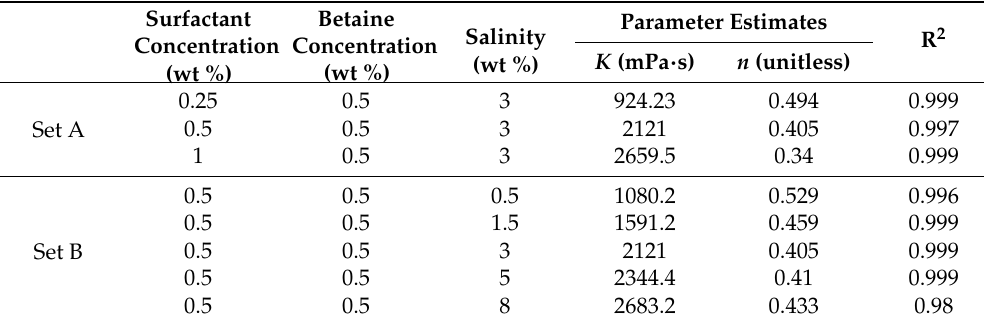
Table 1. Power law parameter estimates for CO 2 foams.